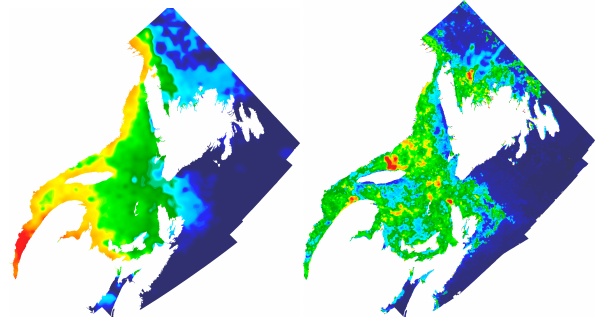
Fig. 10. An example of the ice thickness redistribution (March 5, 2009) by matching the HIGHTSI and feature F 1 distributions. The feature F 1 includes the kinematic features and SAR texture.